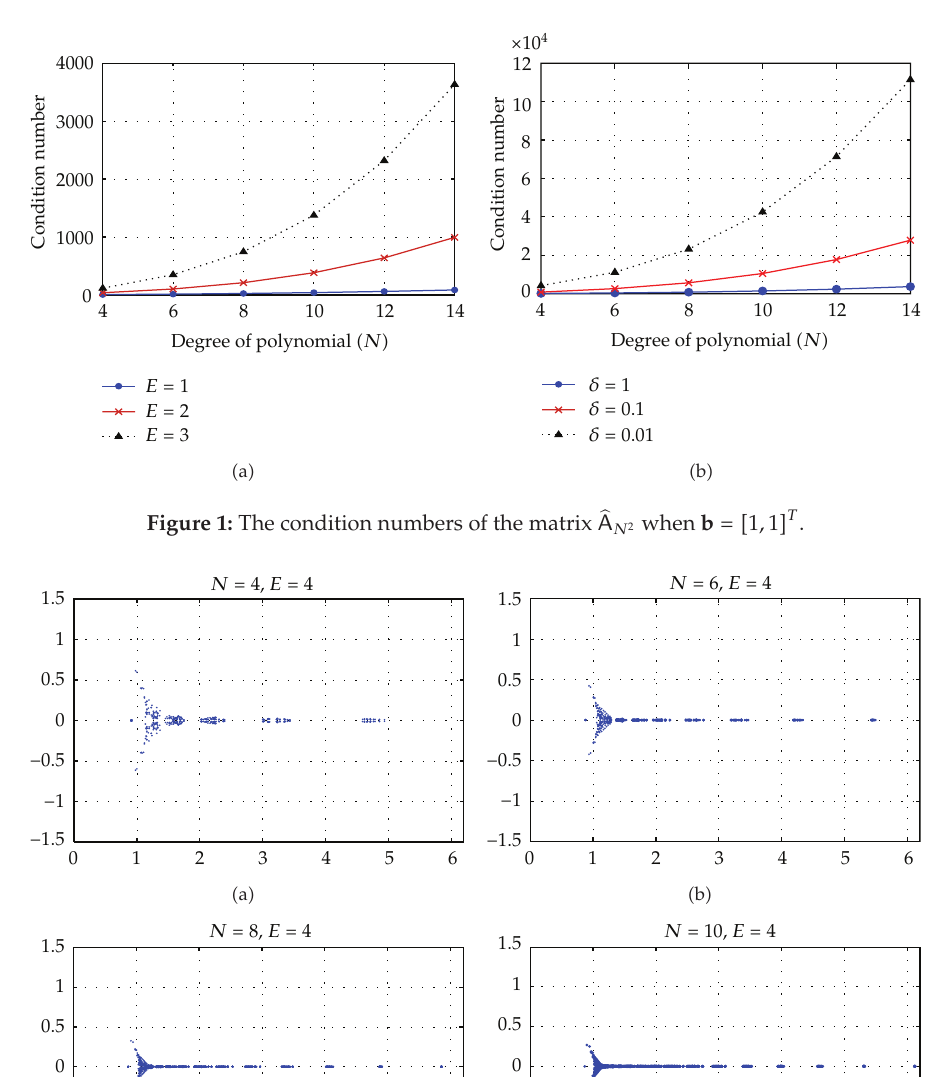
Figure 2: The eigenvalues of